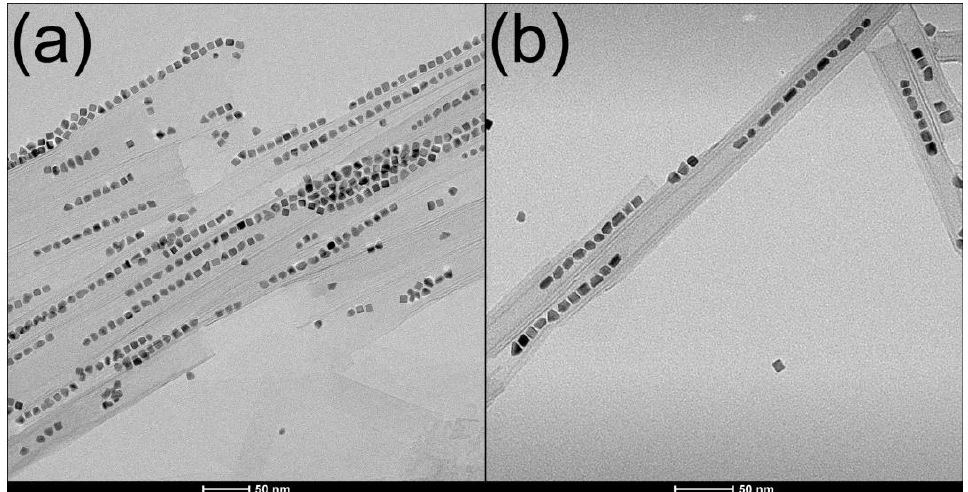
Figure 5. MW-synthesized Pt@HNB NPPs showing good morphology and loading. ( a ) Continuous one-dimensional assemblies of MW-synthesized 8-nm Pt nanocubes are encapsulated within scrolled hexaniobate layers; ( b ) demonstration of consistent interparticle spacing within encapsulated NP arrays.